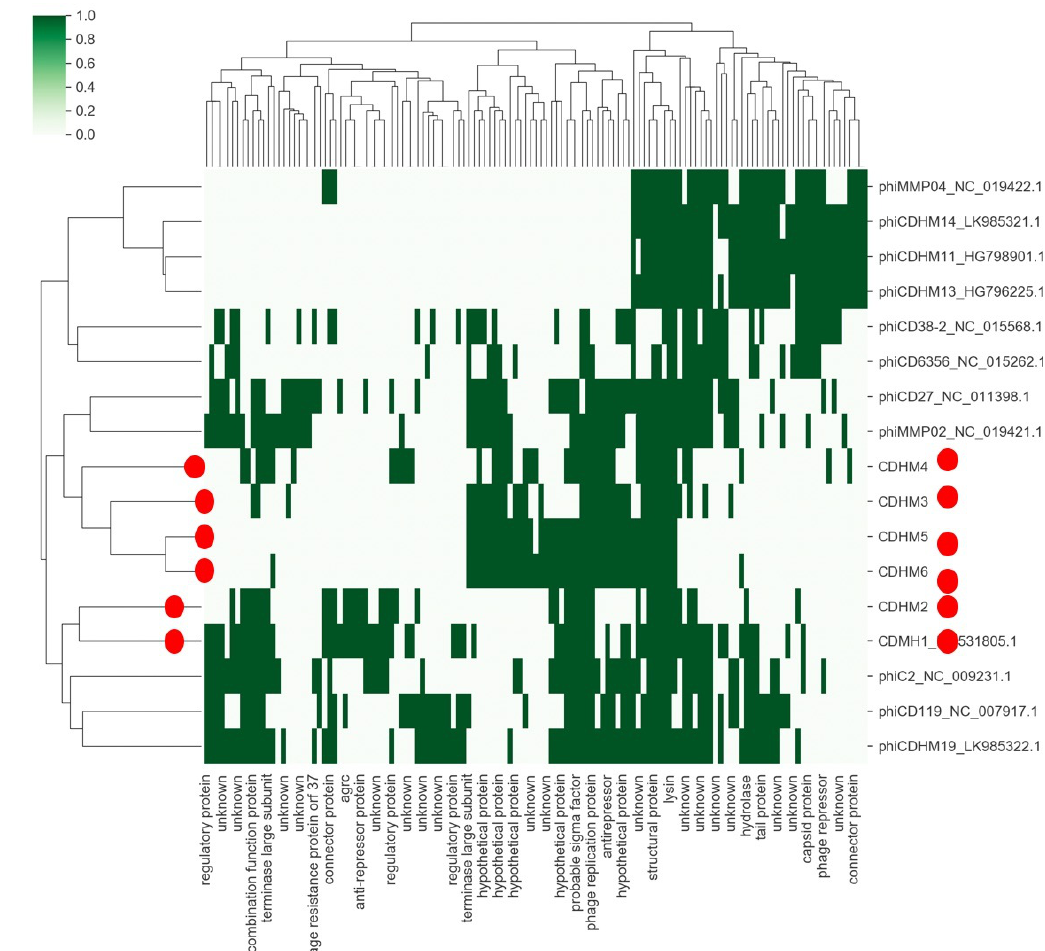
Figure 3. Set of Clostridium difficile phages on the vertical axis, which includes six well-characterised myoviruses from Martha Clokies’ laboratory (red dots). The genes commonly identified in C. difficile phages are shown on the horizontal axis and homologous genes represented by a green line. It is clear that these phages do not share a large common gene